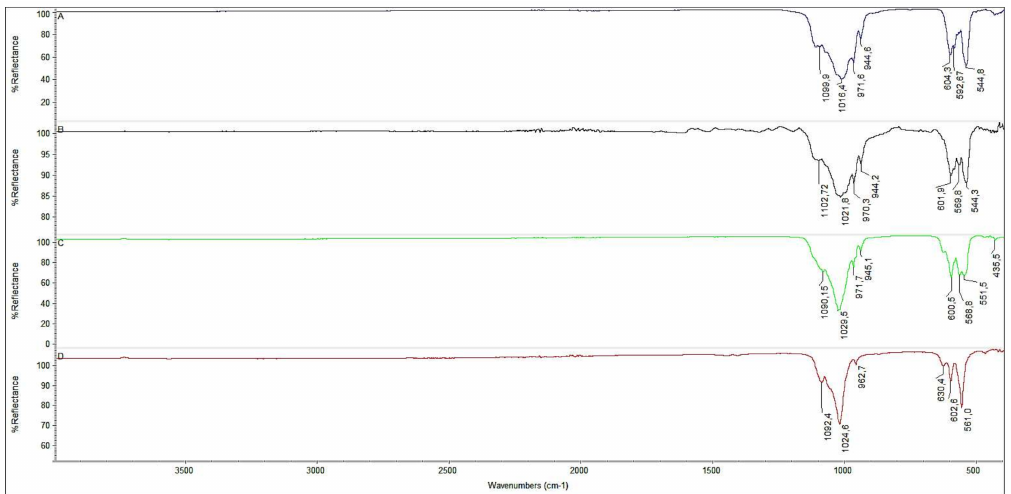
Figure 1. FT-IR spectra of 100% β -TCP ( A ), BCP (( B ) 13% HA—87% TCP, ( C ) 41% HA—59% TCP) and 100% HA ( D